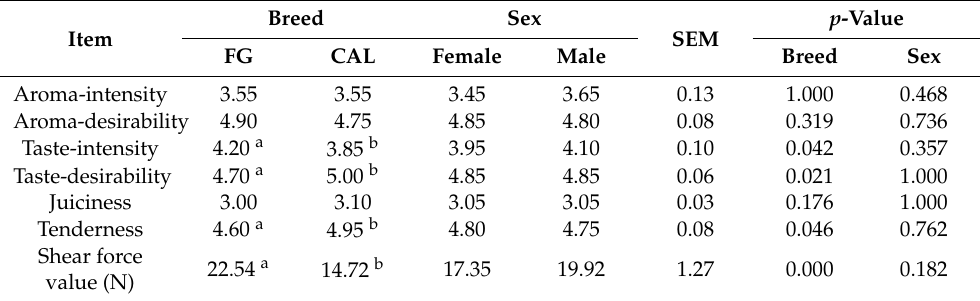
female and male Californian and Flemish Giant Gray rabbits (arithmetic means ±